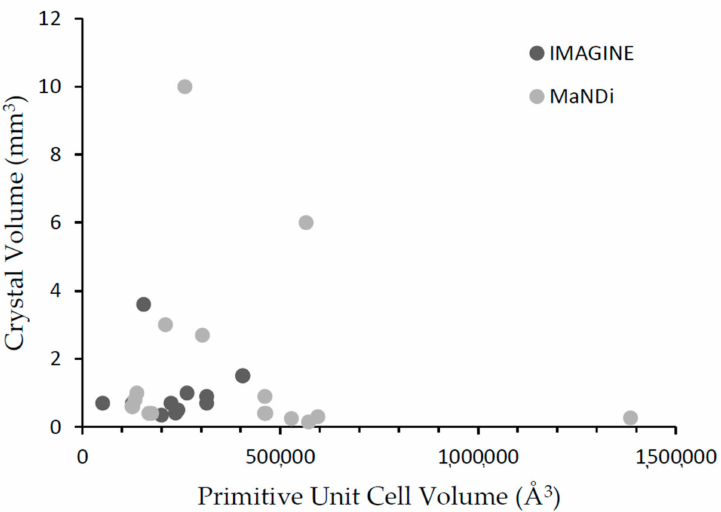
Figure 1. Volume of the crystals used for data collection on IMAGINE and MaNDi plotted against the volume of the primitive unit